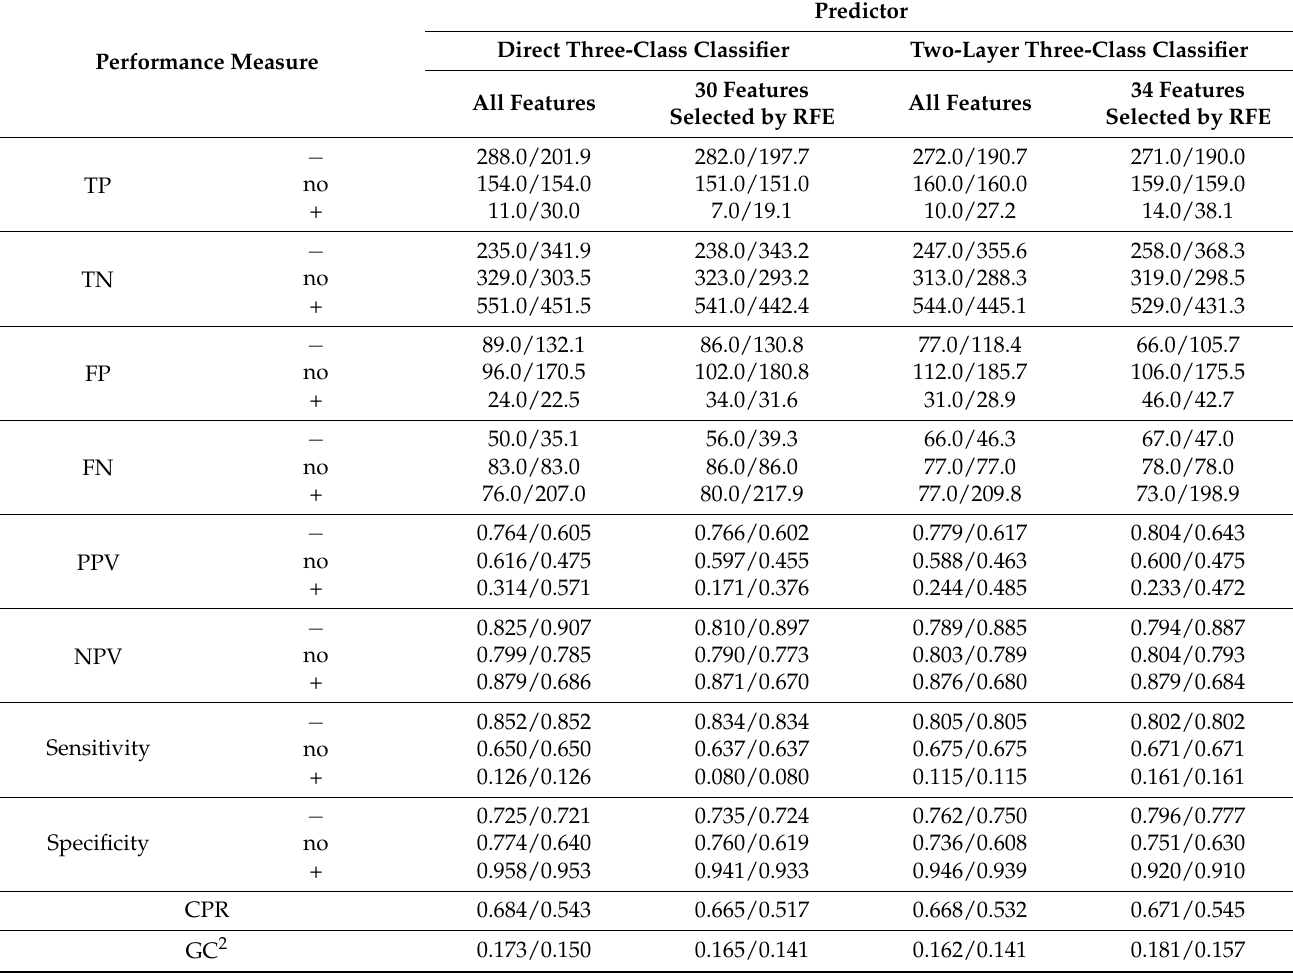
Table 5. Comparison of different three-class LightGBM classifier designs on blind test